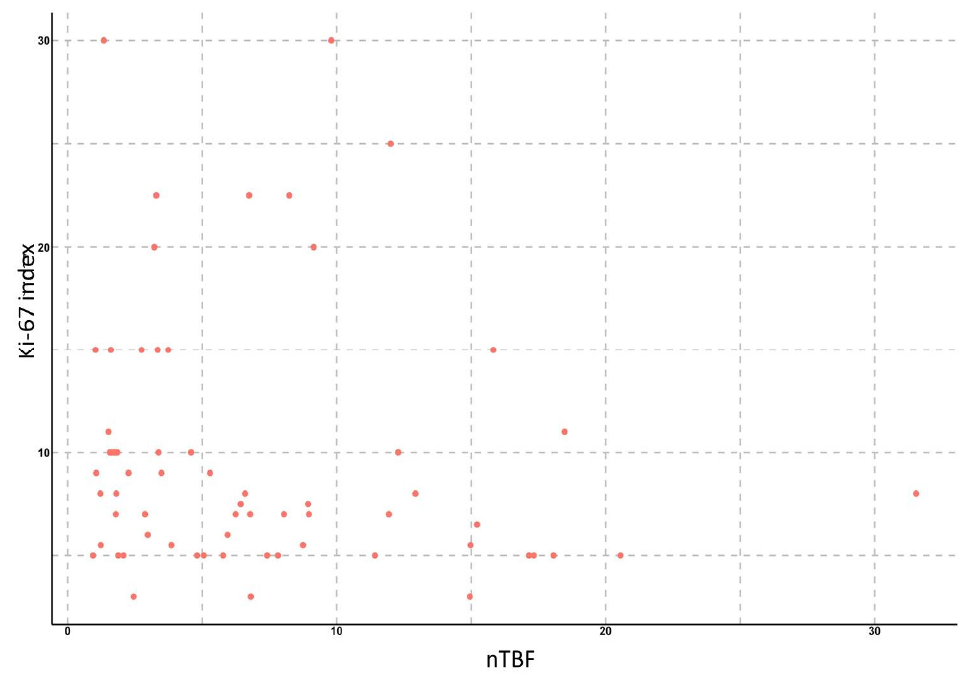
Figure 7. Scatterplot demonstrating the relationship between maximum normalized TBF in gliomas of various grades and Ki-67